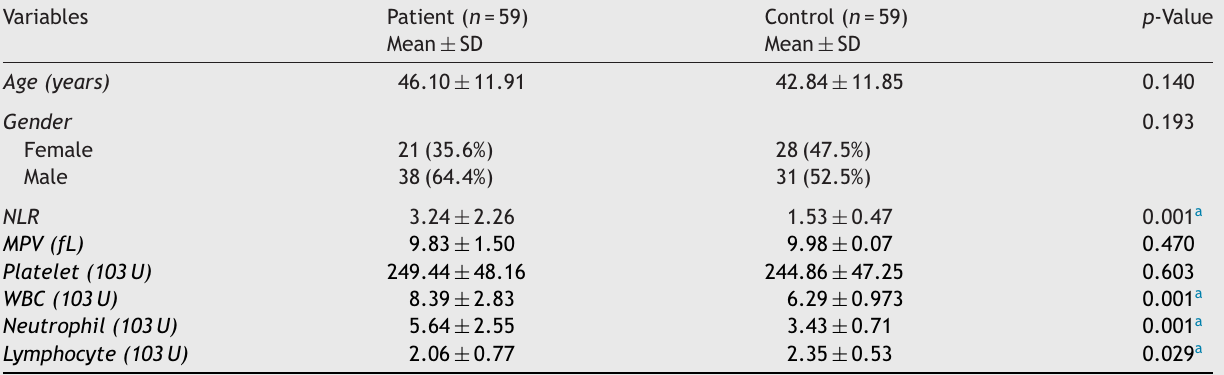
Intergroup comparison of age, gender, mean platelet volume (MPV), neutrophil-to-lymphocyte ratio (NLR) values, and platelet counts of the patients and the control